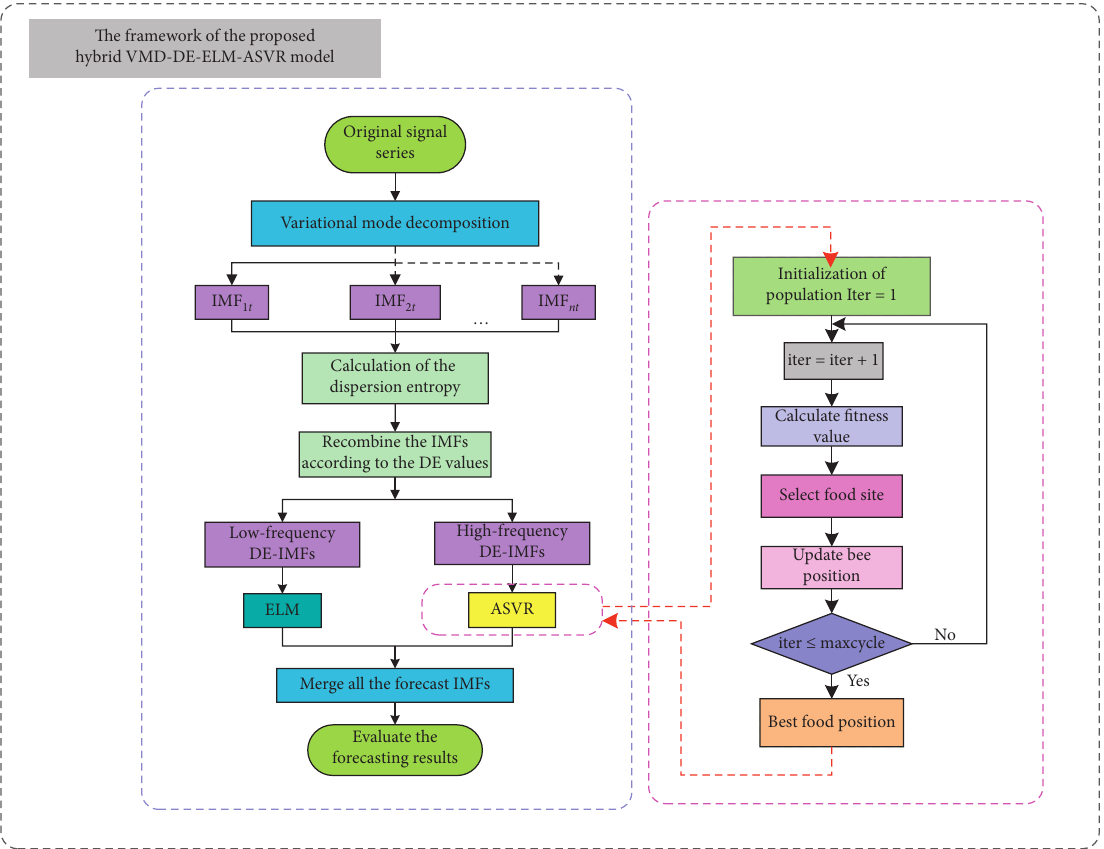
Figure 3: The framework of the proposed hybrid VMD-DE-ELM-ASVR model.